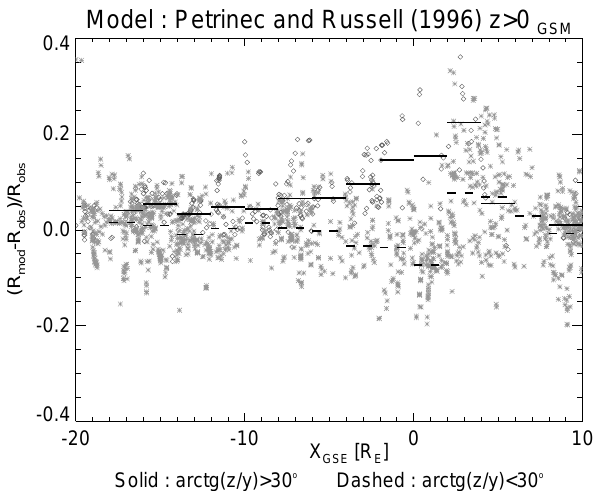
Fig. 2. Distribution of relative deviations of the observed magne- topause crossings from the PR96 prediction along aberrated X GSE axis. Circles and the heavy line refer to high geomagnetic